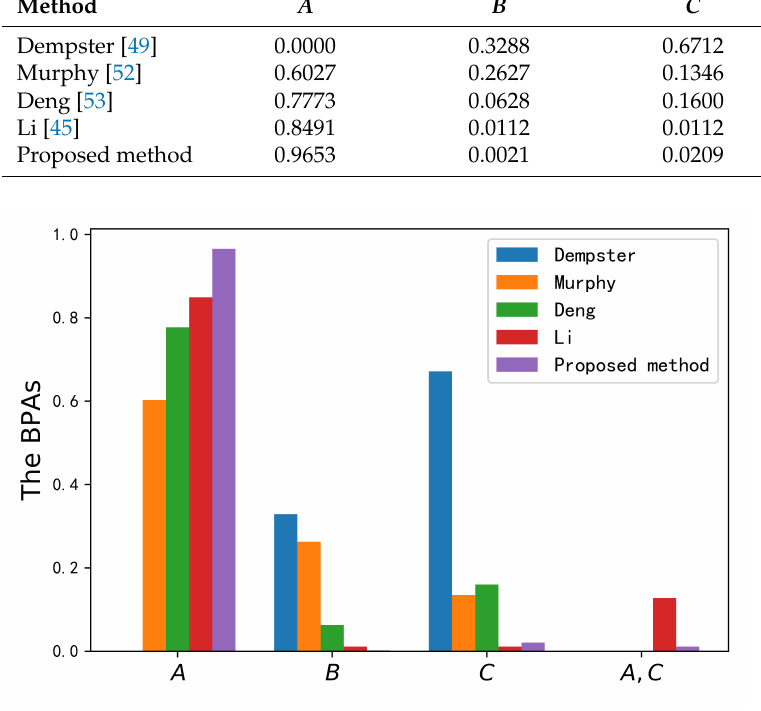
Figure 4. Fusion results from different methods in Application 1.